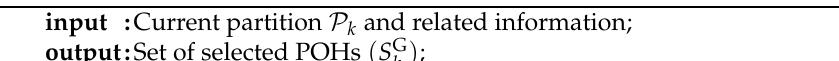
Algorithm 2: Pareto selection enhancing the global